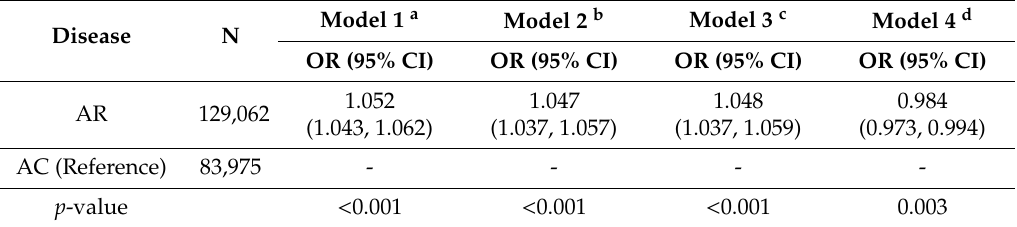
Table 4. Estimated risk of AR relative to AC-associated NO 2 levels (10